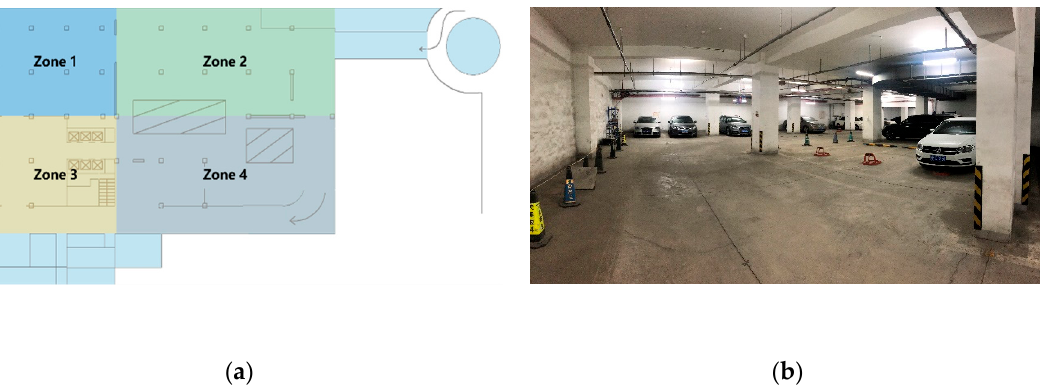
Figure 4. ( a ) Simulation scenario. Zone 1 is the used simulation scene. ( b ) The real scene of zone 1 [22].